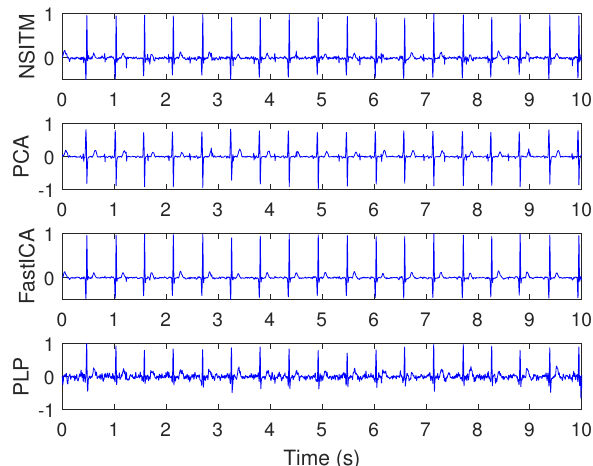
Figure 16. Extracted MECG signals using NSITM, PCA, and FastICA algorithms, using data shown in Figures 13 and 14.The y -axis labels refer to the names of the algorithms used for extracting the MECG